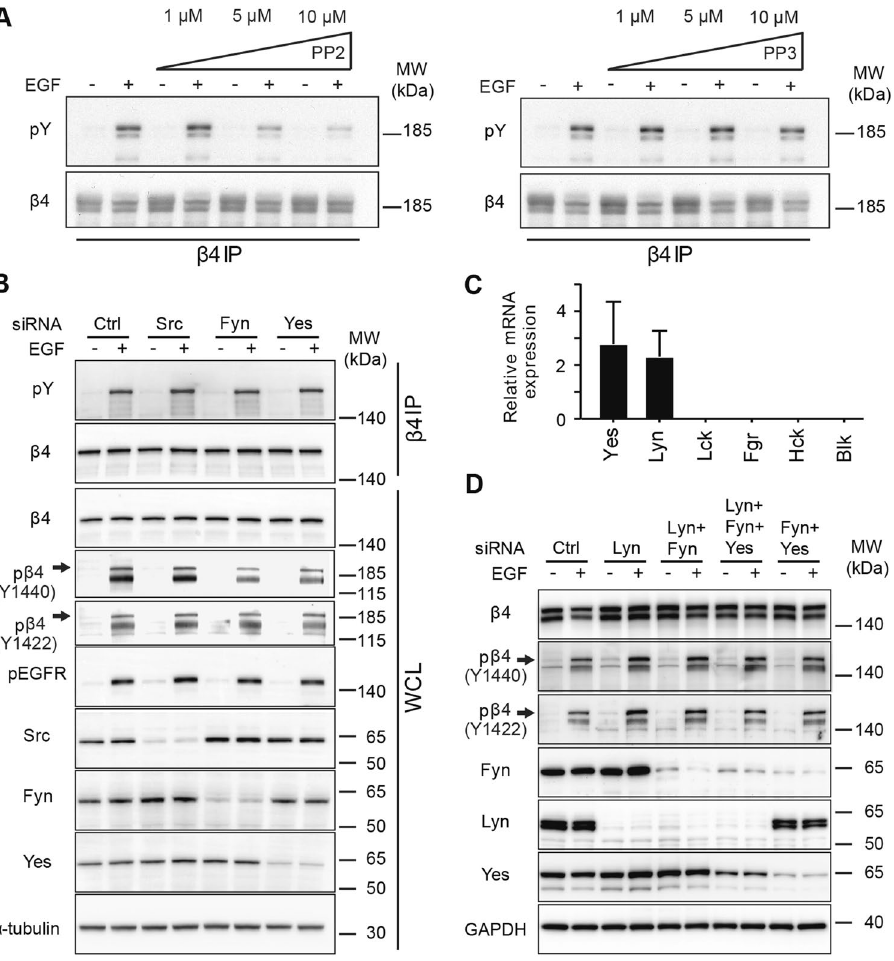
Figure 3. Effects of PP2 and siRNA-mediated knockdown of SFKs on the tyrosine phosphorylation of β4. ( A ) Western blot analyses of β4 tyrosine phosphorylation and total β4 levels in β4 immunoprecipitation (IP) samples of A431-β4-GFP (expressing both endogenous β4 and β4-GFP) cells untreated or treated for 5 min with EGF, after treatment with 0, 1, 5 or 10 µM PP2 or PP3. ( B ) Western blot analyses of β4 IP and WCL samples of WT A431 cells transfected with siRNAs for Src, Fyn and Yes and Ctrl siRNAs, untreated or treated for 5 min with EGF. The blots were proped for phospho-tyrosine (pY), total β4, pβ4 (Y1440), pβ4 (Y1422), pEGFR (Y1068), Src, Fyn, Yes and α-tubulin (loading control). ( C ) Relative mRNA expression of Yes, Lyn, Frk, Lck, Fgr, Hck and Blk SFKs in WT A431 cells analyzed by RT-PCR. Graph shows the mean + SD of 3 independent experiments. ( D ) Western blot analyses of WCL samples of WT A431 cells transfected with siRNAs for Fyn, Lyn and/or Yes or Ctrl siRNAs, untreated or treated for 5 min with EGF. The blots were probed for β4, pβ4 (Y1440), pβ4 (Y1422), Fyn, Yes, Lyn and GAPDH (loading control). Uncropped images of merged chemiluminescent and colorimetric blots obtained with a ChemiDoc imaging system (BioRad) and the repetition of the experiment in ( A ) are shown in Suppl. Fig.